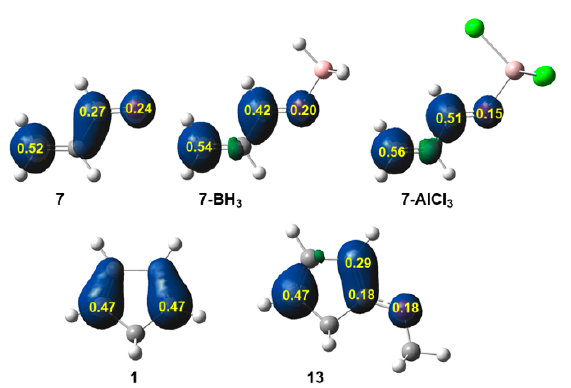
Figure 3. 3D representations of the Mulliken atomic spin densities of the radical anion 7 ·- and those of 7-BH 3 ·− and 7-AlCl 3 ·− , and the radical cation 1 · + and 13 · + together with the electrophilic P + functions of acrolein 7 and the complexes 7-BH 3 and 7-AlCl 3 , and the nucleophilic P − functions of 1 and 13 .